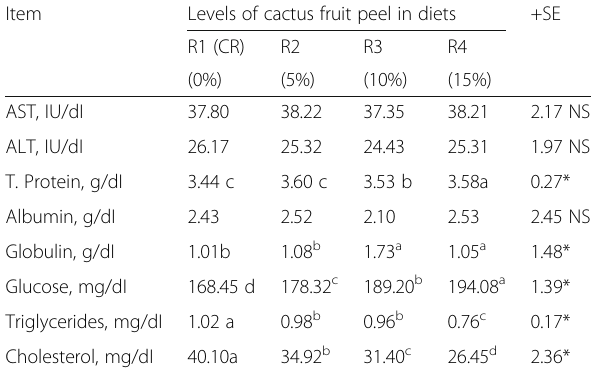
Table 5 Effect of the experimental diets on some blood serum parameters of commercial Cobb broilers